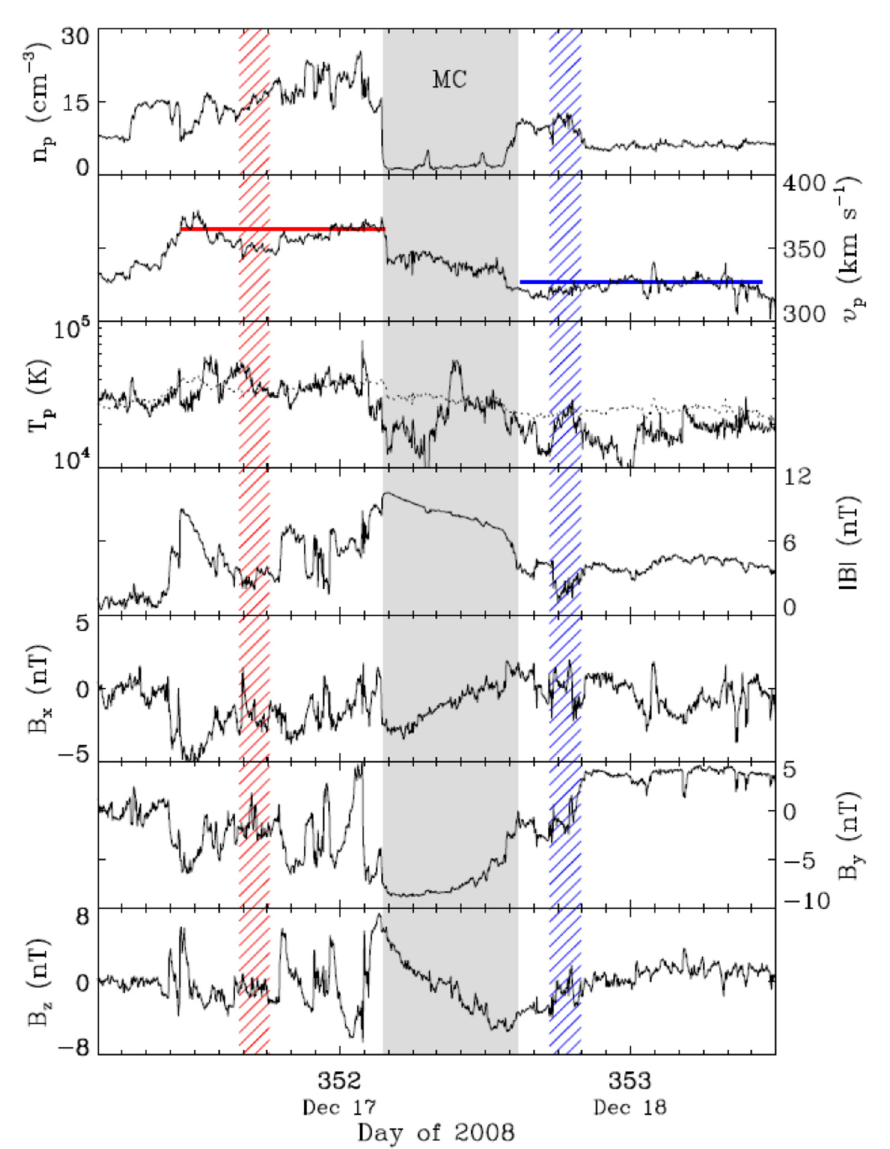
Figure 4. The MC observed at wind corresponding to the 12 December 2008 CME [84]. From top to bottom, the panels show the proton density, bulk speed, proton temperature, and magnetic field strength and components, respectively. The shaded region indicates the MC interval, and the hatched area shows the predicted arrival times (with uncertainties) of the ICME leading and trailing edges. The horizontal lines mark the corresponding predicted velocities at 1 AU. The dotted line denotes the expected proton temperature from the observed speed.